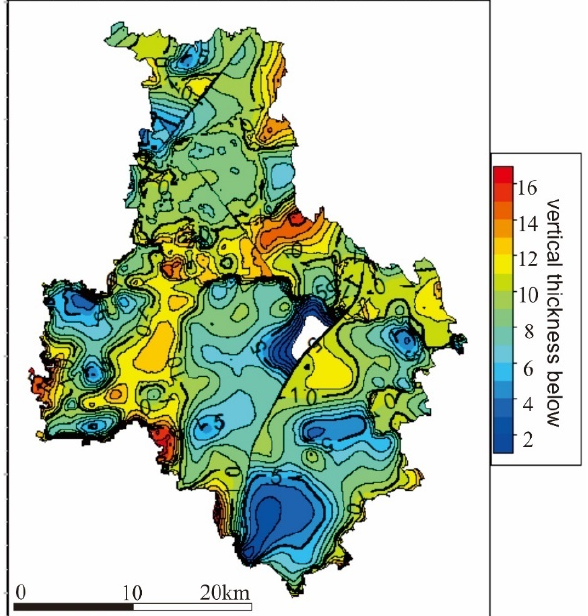
Figure 18. Thickness map of the first sand unit (24) derived from the 3D geological model in the study area. Table 1. Interpreted thicknesses of various units derived from the 3D geological model and bore- hole data.